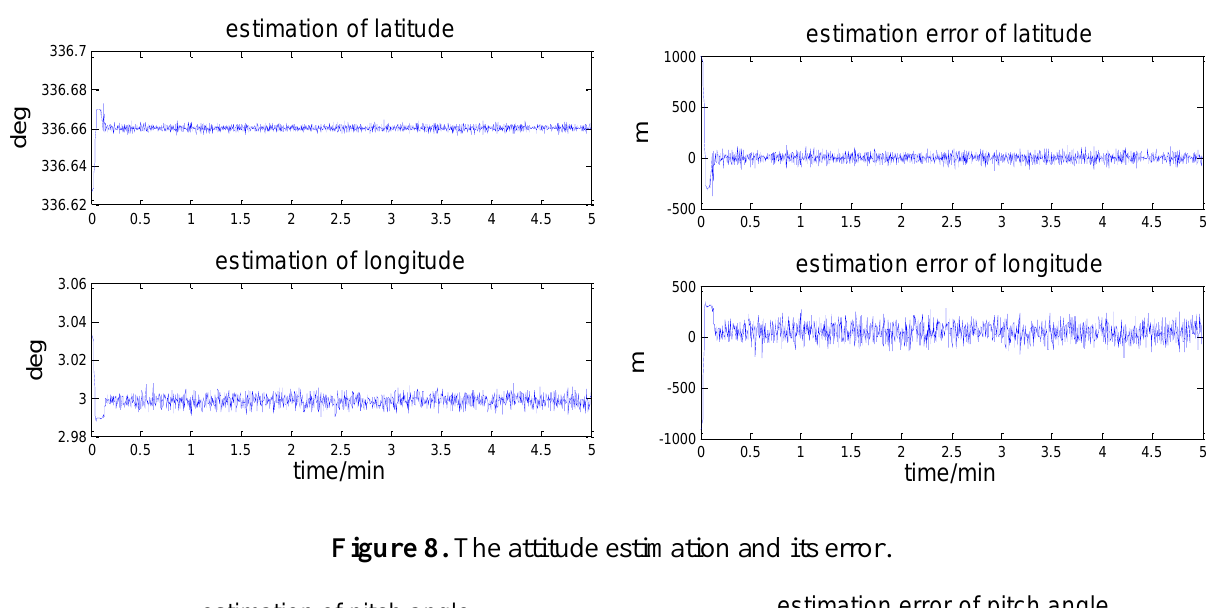
Figure 7. The position estimation and its error.